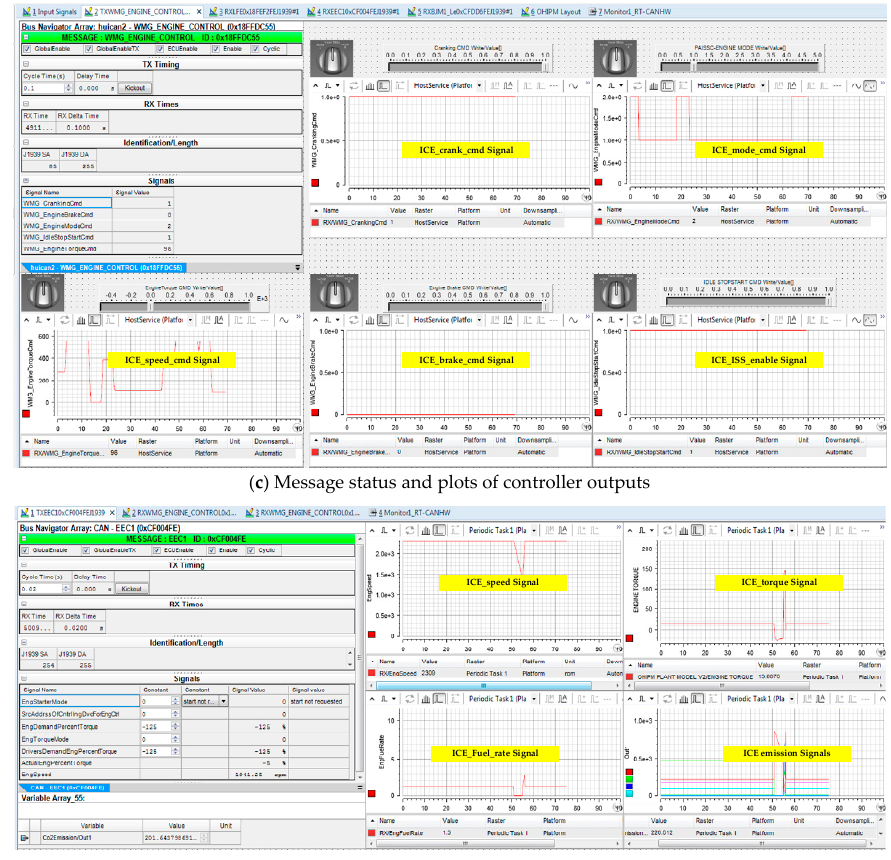
Figure 10. GUI designed for real-time experiment using HIL platform.